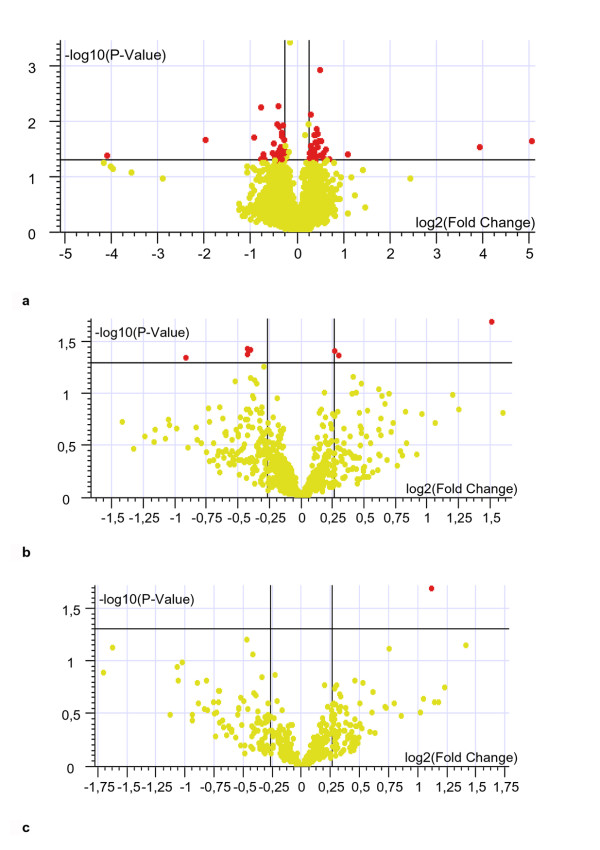
Volcano plots obtained by comparing DS fetuses with and without cardiac defects. Forty-two of the 15,000 analyzed genes are differentially expressed in the 5 samples with cardiac anomalies (CDH) and the 5 samples without cardiac anomalies (DH) (6a). Only a few genes of the ~600 encoding mitochondrial proteins (6b) and of the ~700 encoding ECM proteins (6c), are dysregulated in the CDH vs. DH comparison. Red dots indicate genes differentially expressed with fold change >1.2 and p < .05; yellow dots indicate genes with no significant variation.